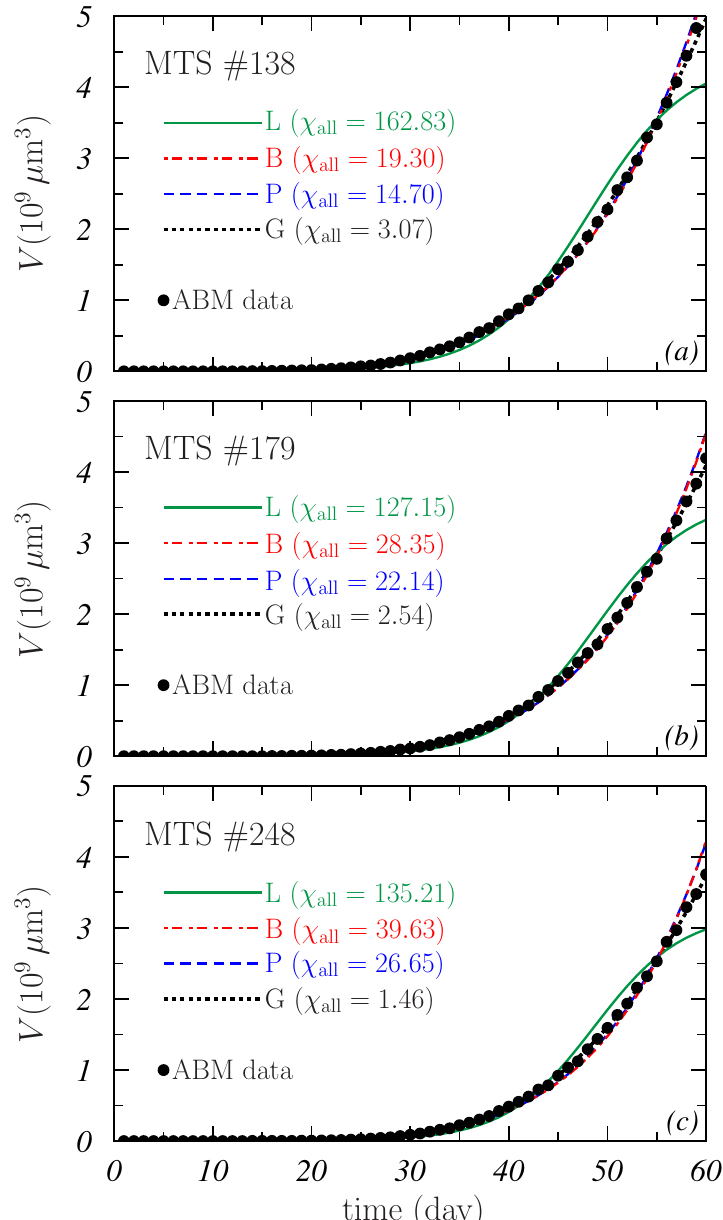
Figure 2. Best fits of the potential (dashed blue lines), Bertalanffy (dotted-dashed red lines), logistic (solid green lines), and Gompertz ( dotted black lines) models to three simulated MTS belonging to sample #1. Black solid circles show the volumes obtained in the ABM simulation. The MTS #138 ( a ) is the spheroid, among all in sample #1, whose data best fit the potential and Bertalanffy models; the MTS #179 ( b ) is the spheroid whose data best describe the logistic model, and the MTS #248 ( c ) is the spheroid whose data best fit the Gompertz model. The values of χ all obtained in each case are also